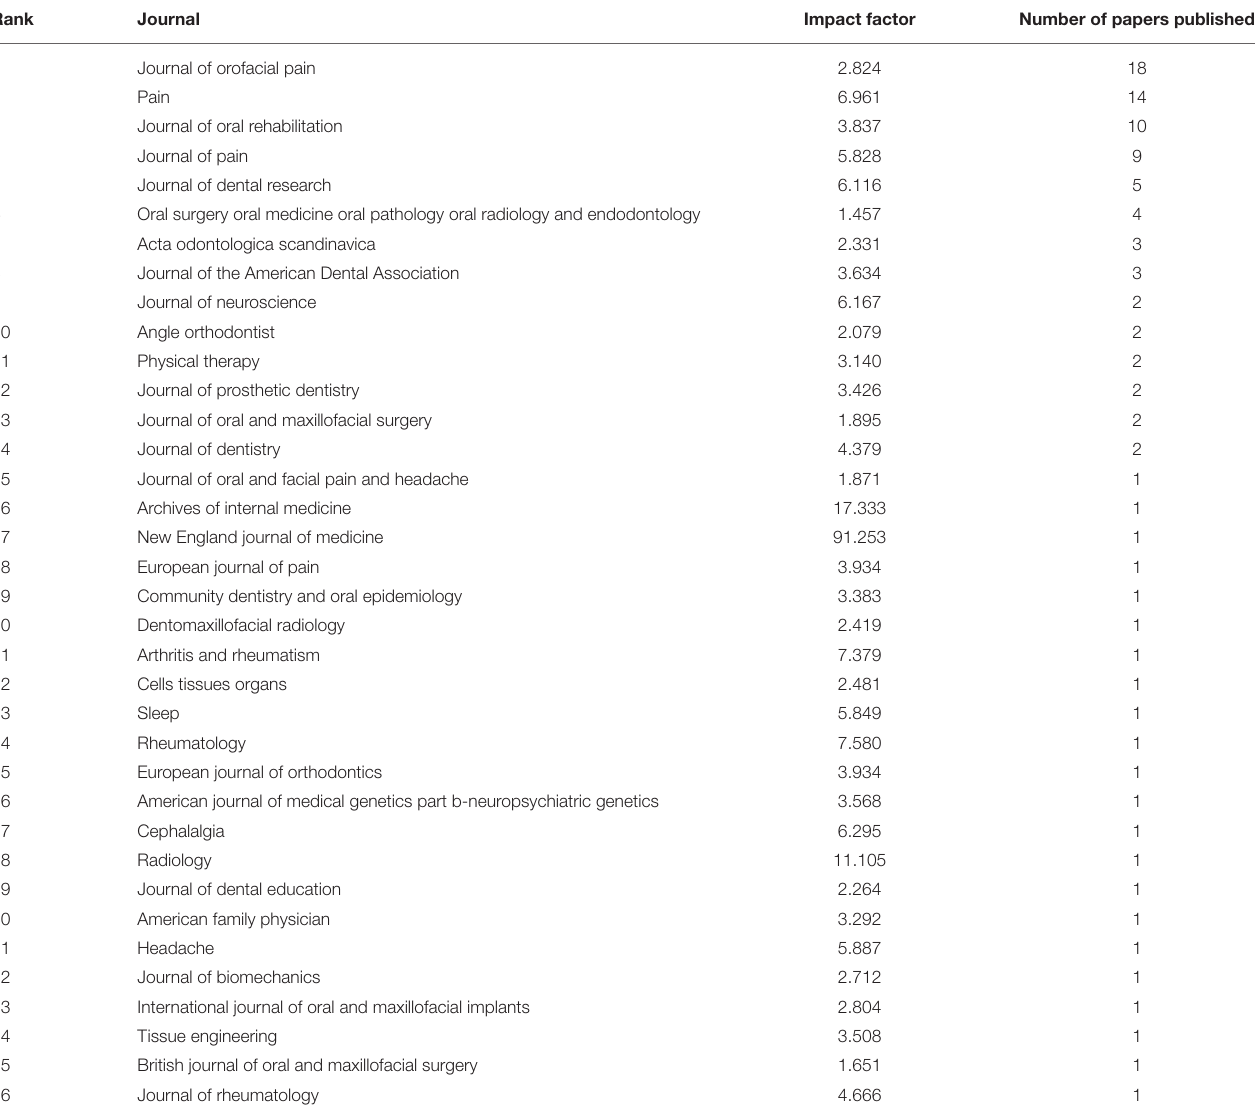
TABLE 3 | Ranking of journal based on number of